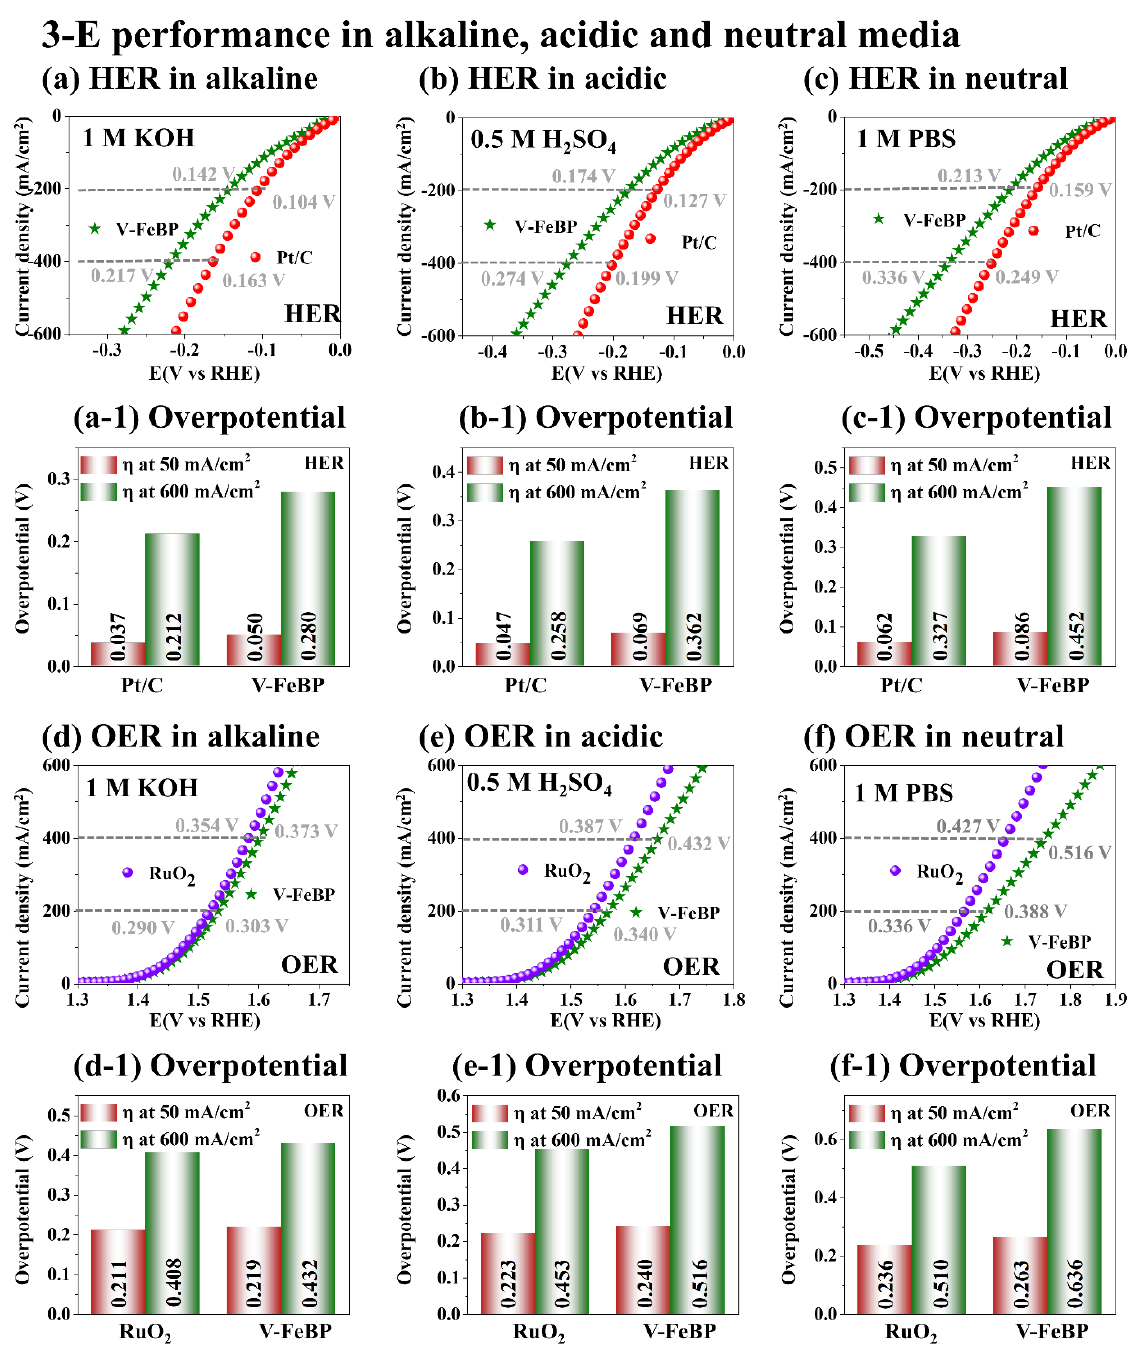
Figure 4. 3-E electrochemical performance comparison of V-FeBP and benchmark electrodes (Pt/C and RuO 2 ) in alkaline, acidic, and neutral waters. ( a – c ) HER curves in 1.0 M KOH, 0.5 M H 2 SO 4 , 1 M PBS. ( a-1 – c-1 ) Corresponding overpotential bar plots at 50 and 600 mA/cm 2 . ( d – f ) HER curves. ( d-1 – f-1 ) Corresponding overpotential bar plots.